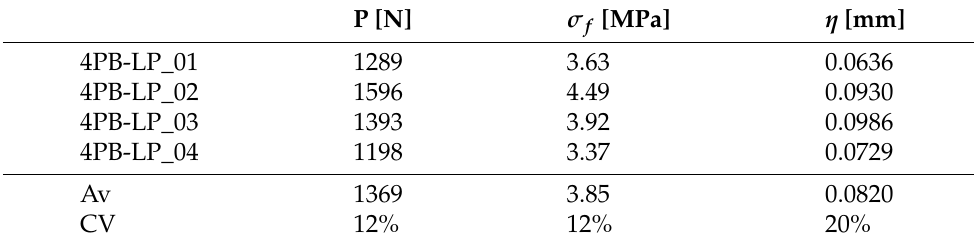
Table 6. Results of four-point bending tests (4PB-LP) in terms of maximum load P and corresponding vertical displacement η and flexural stress σ f according to the classical mono-modulus beam